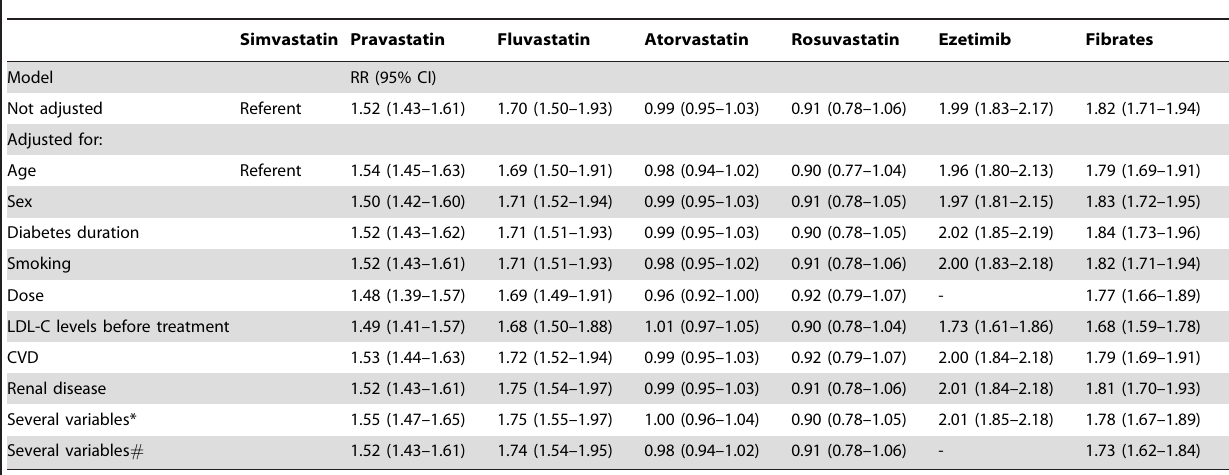
Table 5. Relative risks and 95% confidence interval of lipid level $ 2.5 mmol/L in patients taking other lipid lowering agents than simvastatin compared to taking